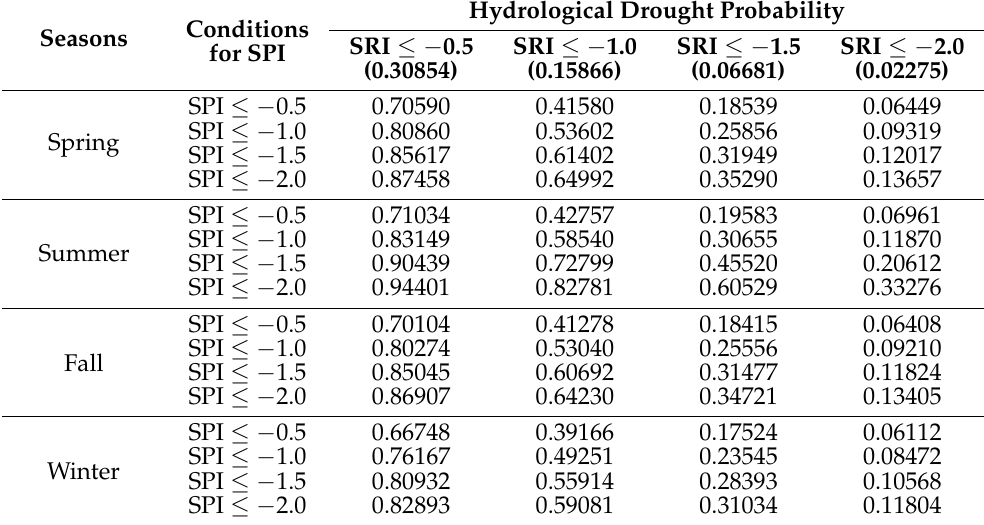
Table 5. Propagation probability of hydrological drought under various seventies of meteorological drought at Andong Dam Basin.